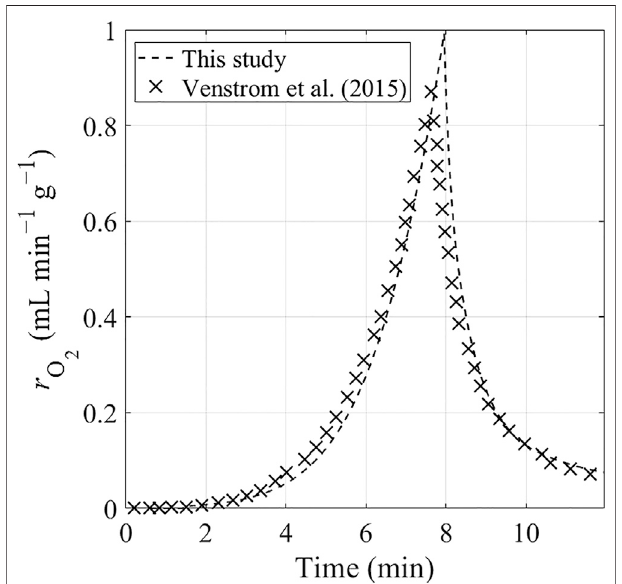
FIGURE 7 | Transient O 2 production rate from reduction reaction of fi xed-bed ceria predicted by two numerical models: the model developed by Venstrom et al. (2015) (represented by the crosses) and the present model (represented by the dashed curves). The reduction reaction is operated under an increasing temperature and a constant N 2 fl ow.